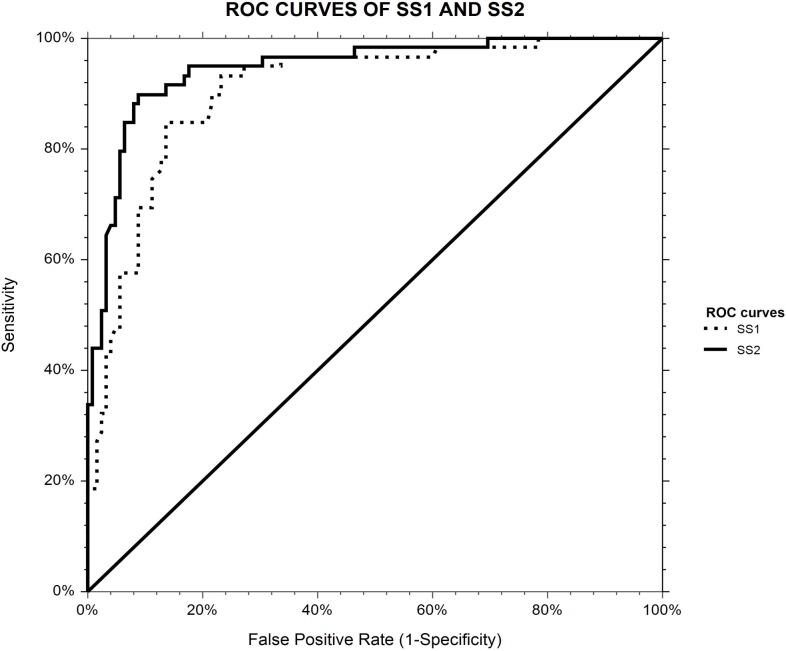
ROC curves of SS2 and SS1 scores for the prediction of sarcopenia one year after sleeve gastrectomy.The diagonal line represents the detection achieved by chance alone (AUROC = 0.50); the ideal AUROC is 1.00. The SS1 score takes into account SMA [skeletal muscle cross-sectional area at the third lumbar vertebrae (cm2)] and gender. The SS2 score takes into account SMI [skeletal muscle index: SMA/height2 (cm2/m2)] and gender.